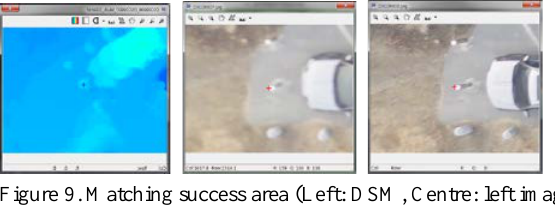
Figure 9. Matching success area (Left: DSM, Centre: left image, Right: right image)